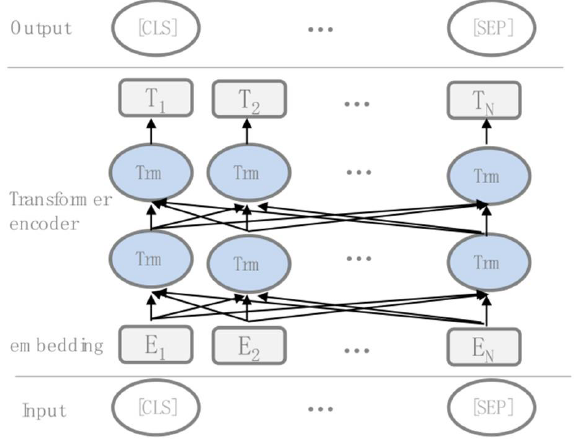
Figure 2. Structure of BERT model.